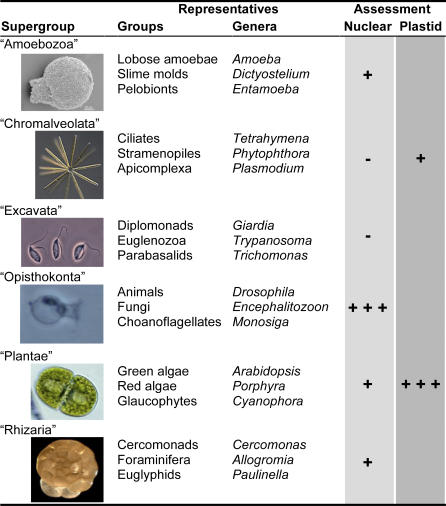
Summary of Eukaryotic SupergroupsAssessment based on our analysis of molecular genealogies. +++, well supported; +, some support; −, support missing or very limited. Nuclear, genealogies based on nuclear genes. Plastid, genealogies based on chloroplast genes. Pictured organisms: Lesquereusia, Thalassionema, Jakoba, Proterospongia, Cosmarium, Ammonia. (Images: micro*scope, http://starcentral.mbl.edu/microscope).